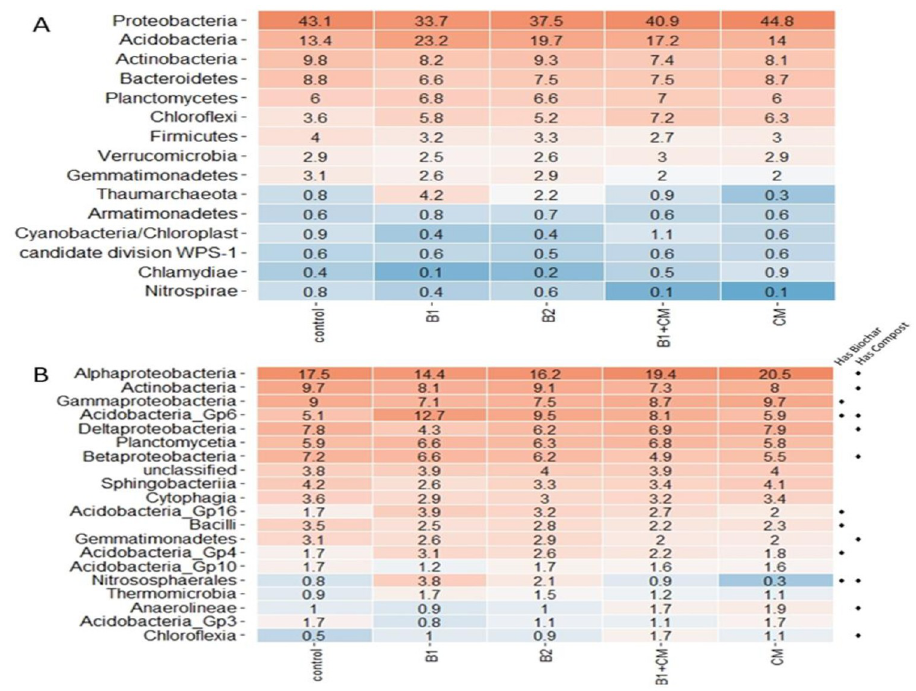
Fig 3. Heatmap depicting the dominant bacterial phyla (A) and classes (B) in the turfgrass plot soils. ♦ symbols identify classes that were important in delineating the soil treatments (presence or absence of biochar or compost) based on Random Forest analyses (%MSE in upper 25% range). Treatments include unamended control (CK), 12.5 t ha -1 biochar (B1), 25 t ha -1 biochar (B2), 5 centimeter (cm) green waste compost (CM), and 12.5 t ha -1 biochar and 5 cm compost